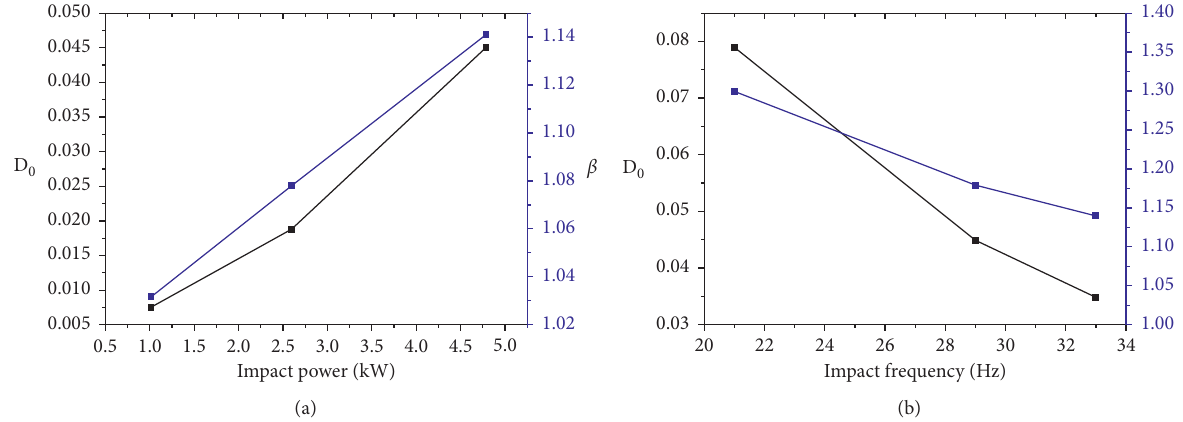
Figure 14: Variation of surrounding rock damage D 0 and damage ratio β : (a) with impact power; (b) with impact